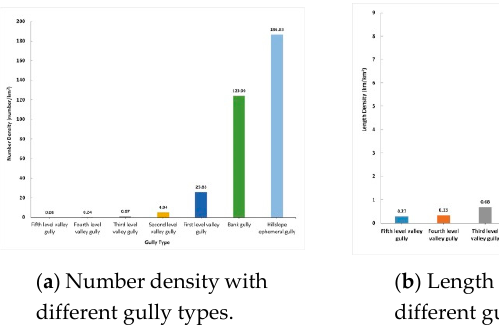
Figure 6. Quantitative characteristics of the gully system.